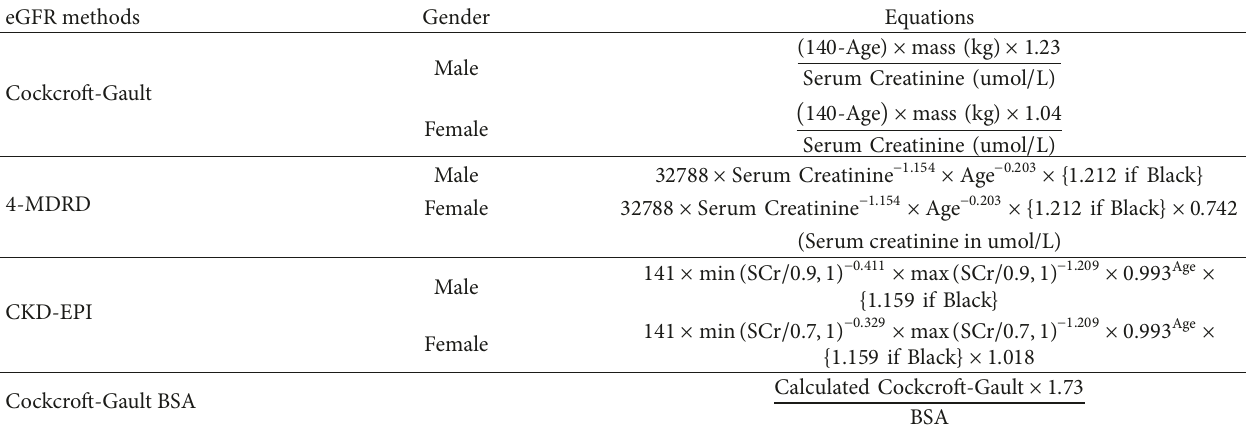
Table 1: Different eGFR formula according to gender.